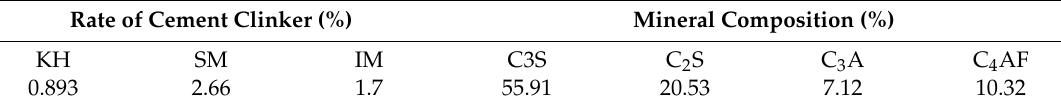
Table 2. Rate of cement clinker mineral composition.